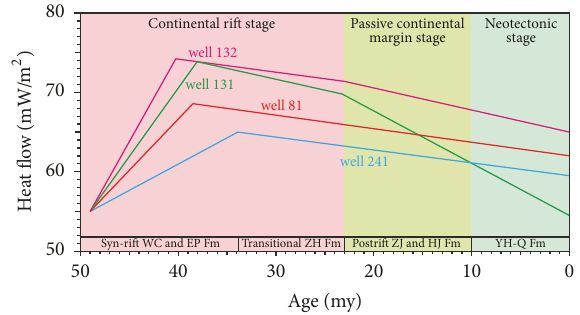
Figure 16: Variable paleoheat flow model applied in Transient Heat Flow Method of the Huizhou Sag (the locations of wells are shown in Figure